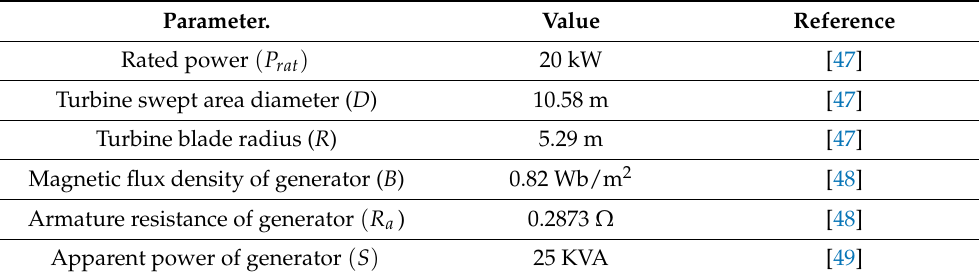
Table 3. Technical specification of the 20 kW wind turbine